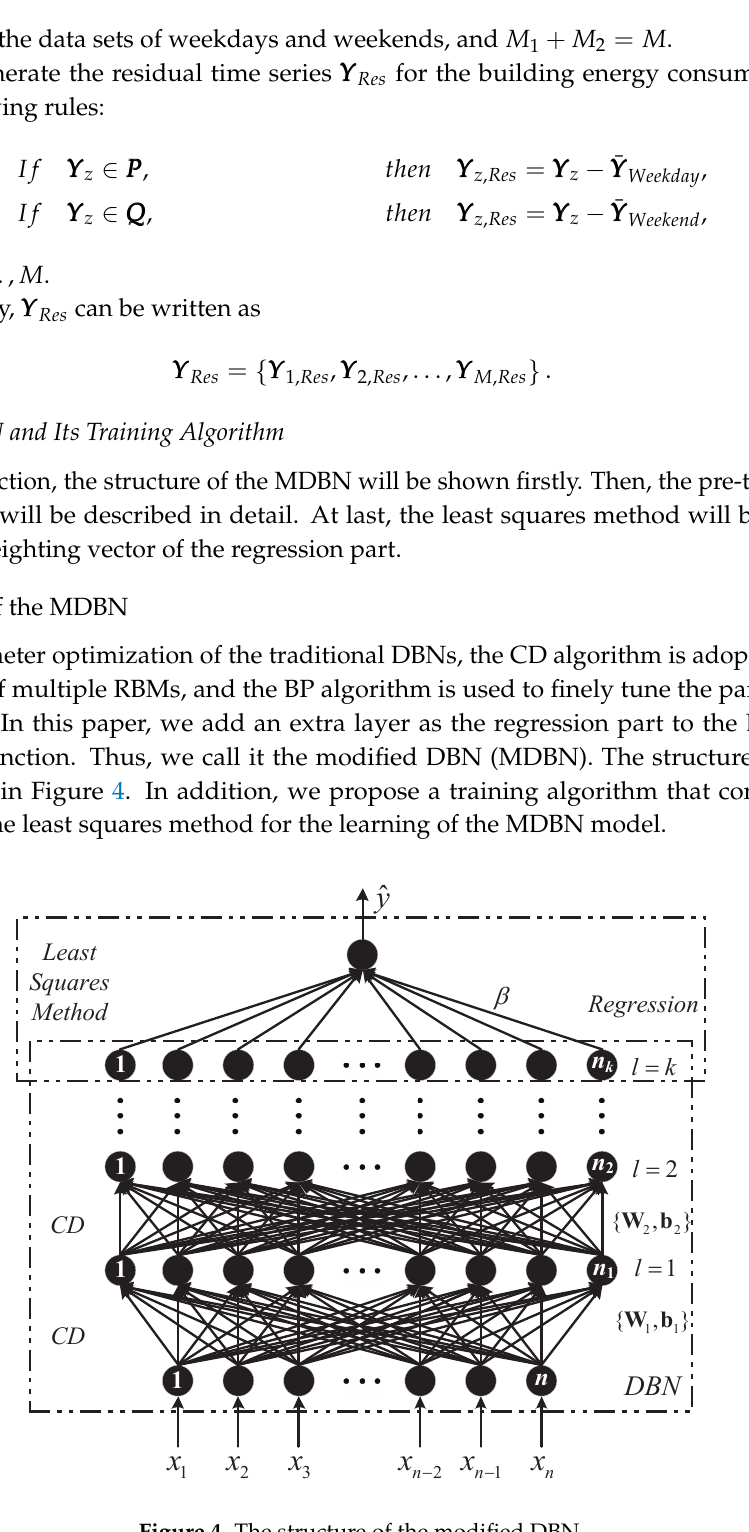
Figure 4. The structure of the modified